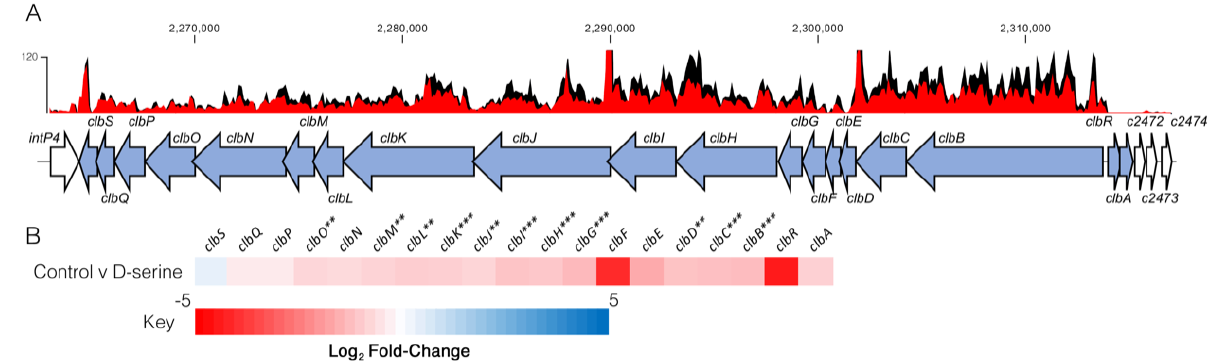
FIGURE 1: Transcriptome analysis of CFT073 reveals downregulation of the colibactin biosynthesis operon in response to D-Serine. Using read data from our previous transcriptomic study [21], we constructed track maps of the clb locus in CFT073 in the presence and absence of D-Serine. ( A ) Read density in the colibactin biosynthesis locus for representative samples of the untreated control (black) and D-Serine treated (red) CFT073 is indicated. Read tracks were normalized , exported from CLC Genomics Workbench and overlayed. Genomic coordi- nates are displayed above the read tracks and the corresponding genes within the colibactin biosynthesis operon (blue) beneath. ( B ) Heat map indicating the EdgeR calculated log 2 relative fold changes for each gene in the colibactin biosynthesis locus with corresponding colour key beneath. False discovery rate-corrected P values are indicated with significantly differentially expressed genes with *, ** and *** indi- cating P < 0.05, 0.01 and 0.001, respectively